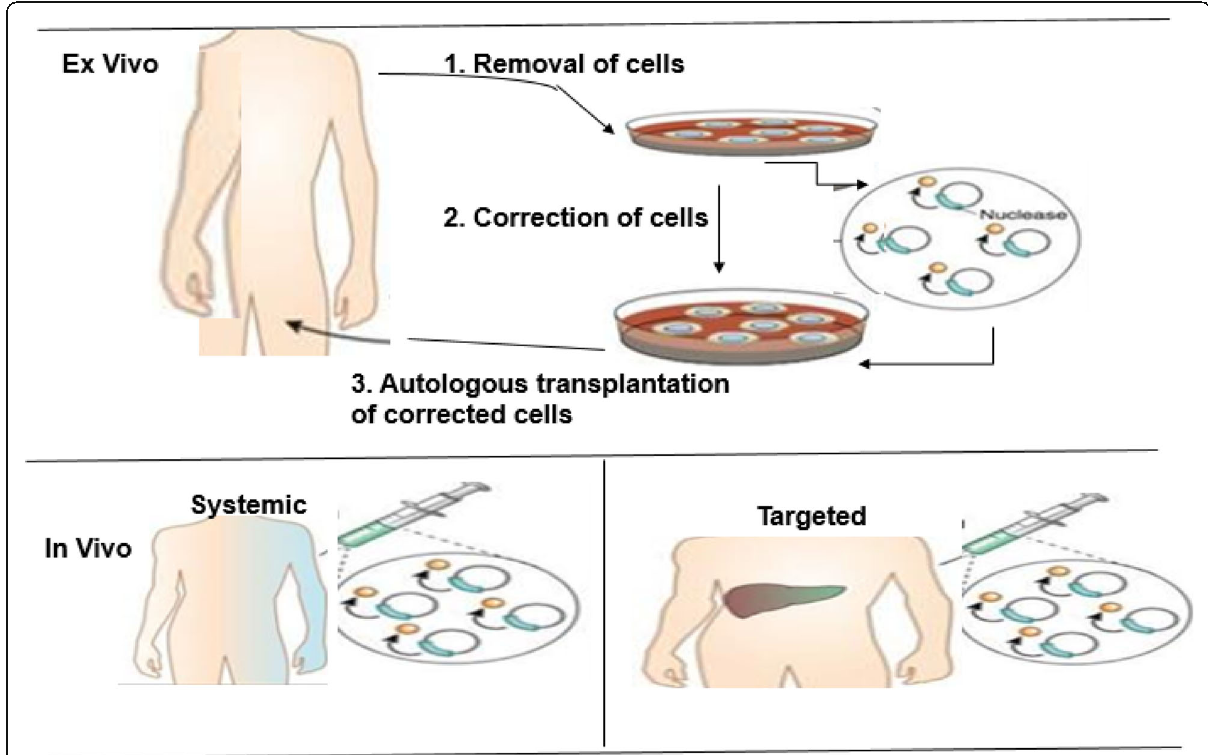
Fig. 7 Outline of the ex vivo and in vivo genome editing procedures for clinical therapy. Top: In the ex vivo editing therapy, cells are removed from a patient to be treated, corrected by gene editing and then re-engrafted back to the patient. To achieve therapeutic success, the target cells must be capable of surviving in vitro and autologous transplantation of the corrected cells. Below: In the in vivo editing therapy, designed nucleases are administered using viral or non-viral techniques and directly injected locally to the affected tissue, such as the eye, brain, or muscle. (Adapted from